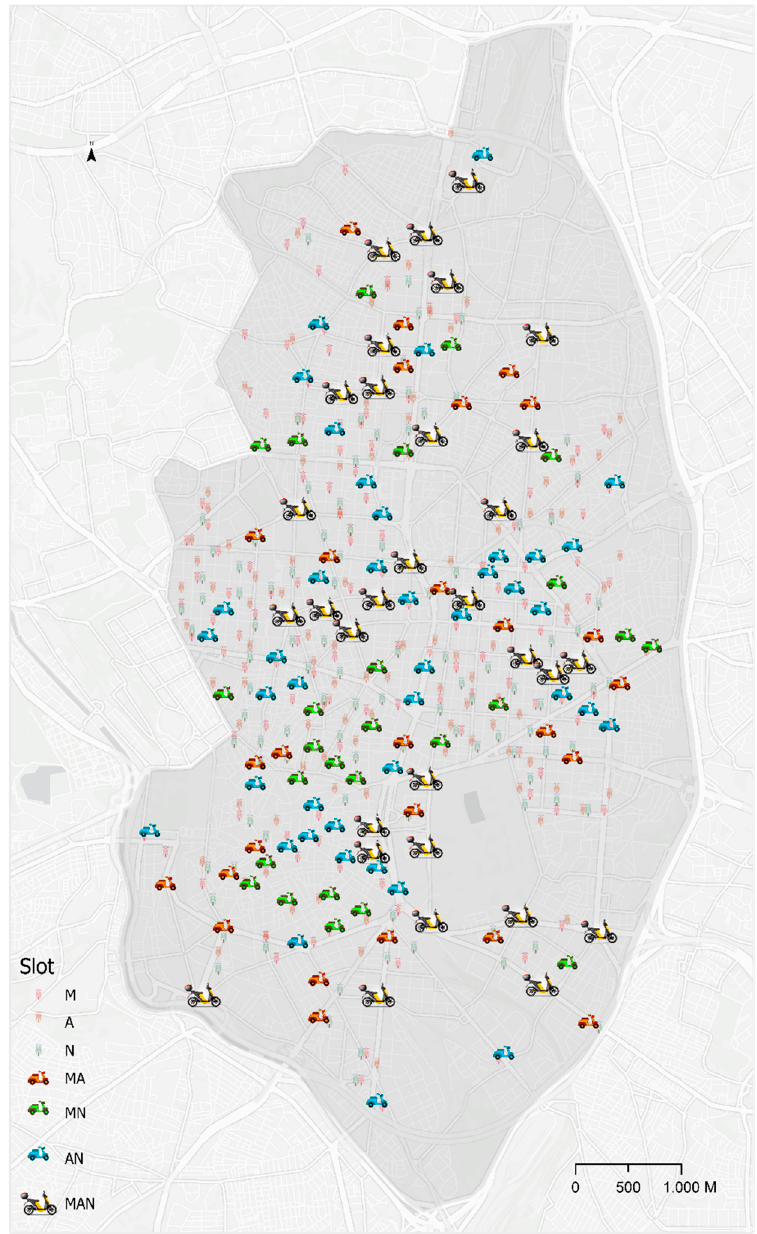
Figure 10. Partial scenarios: Number of parking spaces by time band in which they appear active.